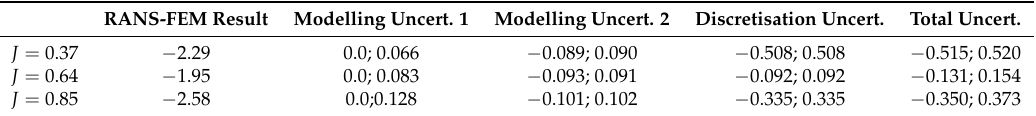
Table 9. Uncertainties (lower and upper levels) in twist deformation at the tip in ( ◦